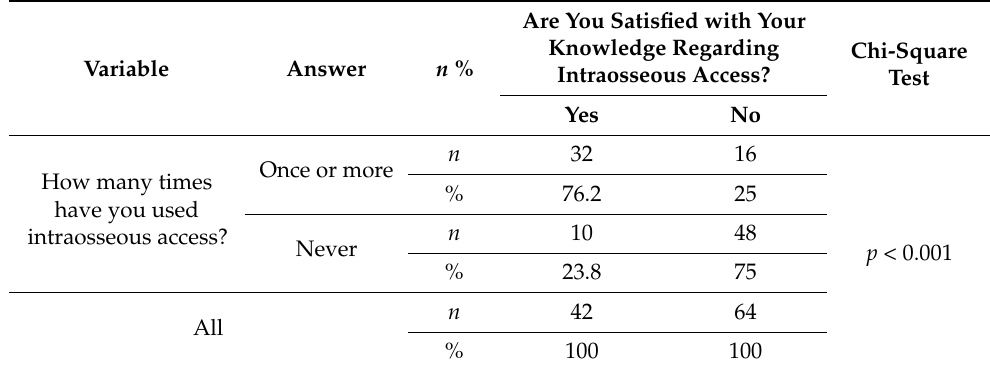
Table 7. Satisfaction with knowledge regarding intraosseous access vs. number of insertions of intraosseous